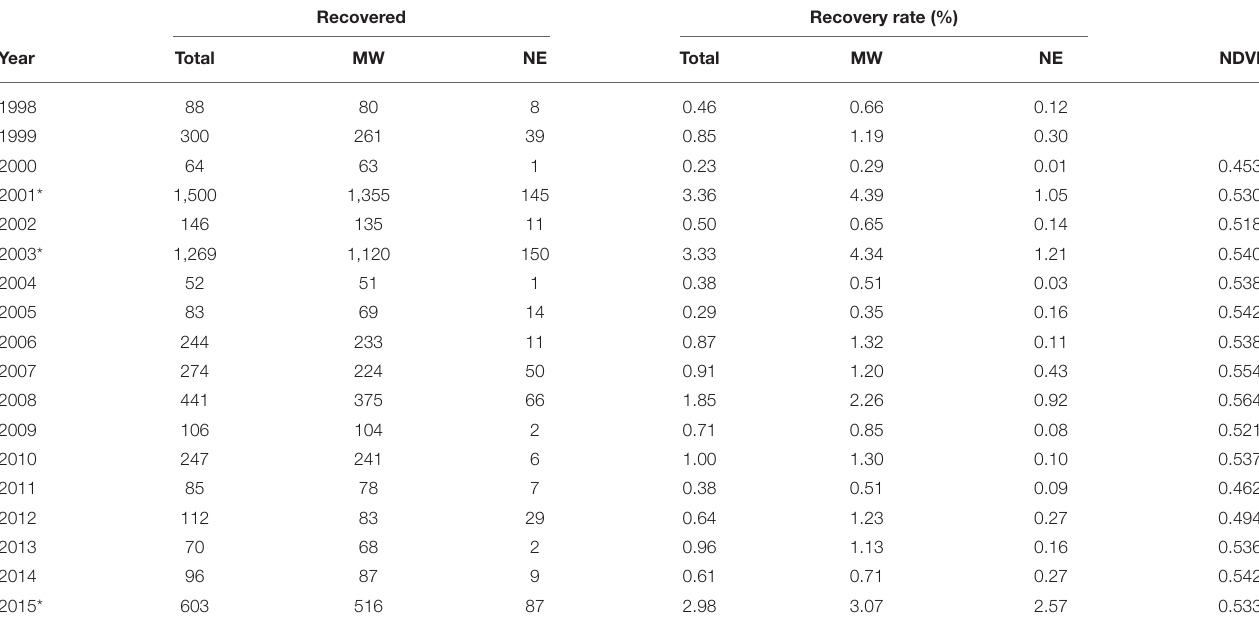
TABLE 3 | The number of recoveries and recovery rates for wild-caught butterflies for the total monarch range north from 40 to 50 ◦ latitude and east from 100 to 65 ◦ longitude and for the Midwest and Northeast (see Figure 1